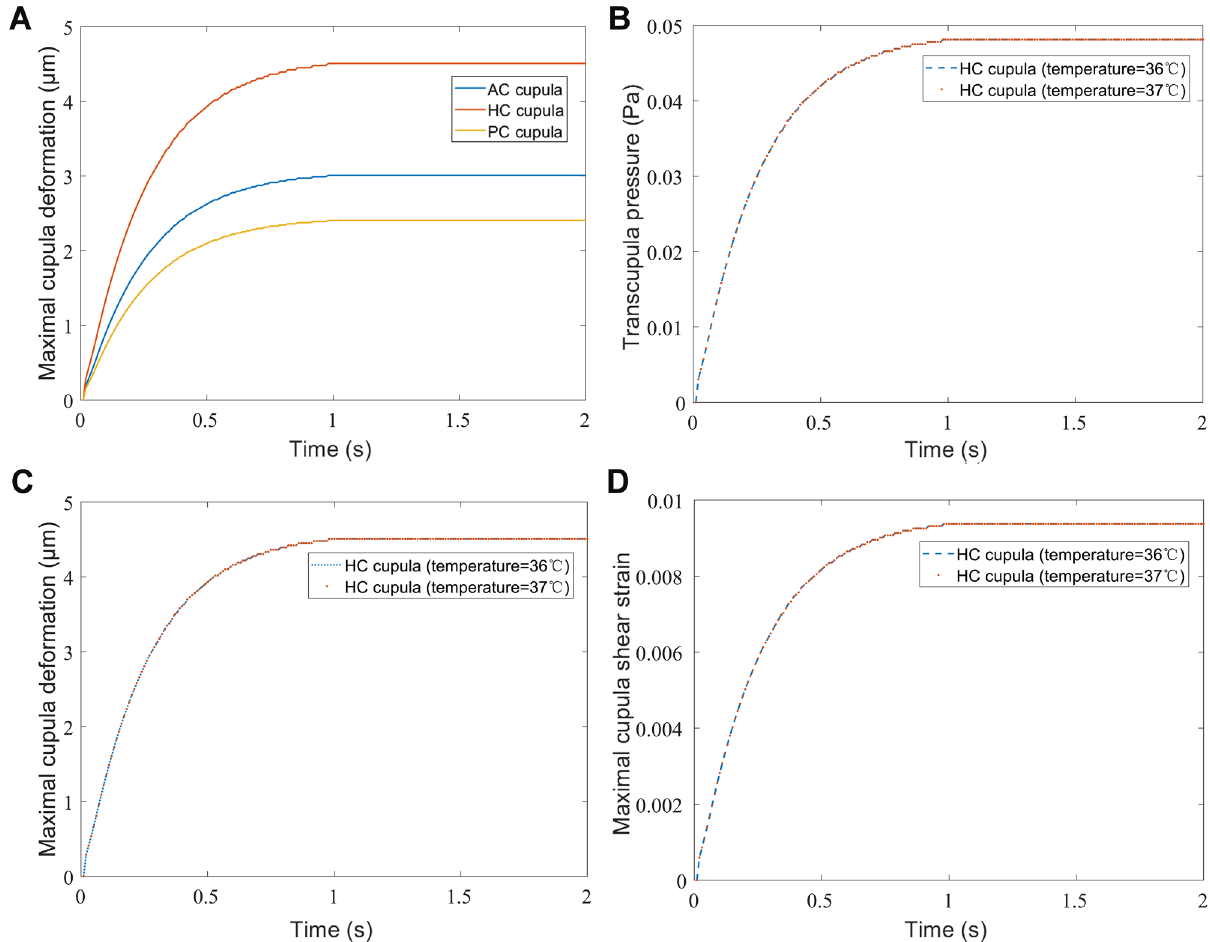
Figure 4. ( A ) The maximal cupula deformation changing with time. ( B ) The maximal transcupular pressure changing with time under condition of 36 °C and 37 °C, respectively. ( C ) The maximal cupula deformation changing with time under condition of 36 °C and 37 °C, respectively. ( D ) The maximal cupula shear strain changing with time under condition of 36 °C and 37 °C, respectively.